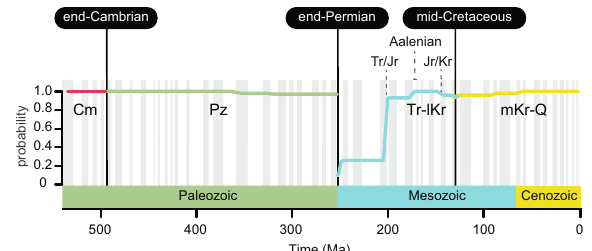
Fig. 2 Phanerozoic oceans sequentially harbored four global benthic mega-assemblages. The per stage signi fi cance measures the probability of retrieving a given mega-assemblage across 100 bootstrapped solutions and captures the global instability of the modular structure in the assembled network after the end-Permian 49 and subsequent Late Triassic and Early Jurassic extinction events 42 . Mega-assemblage shifts occur at the following boundaries: End-Cambrian (combined Paibian/Jiangshanian to Age10), end-Permian (Changhsingian to Induan), and mid-Cretaceous (Hauterivian to Barremian). Cm Cambrian, Pz Paleozoic, Tr-lKr Triassic to lower Cretaceous, mKr-Q mid-Cretaceous to